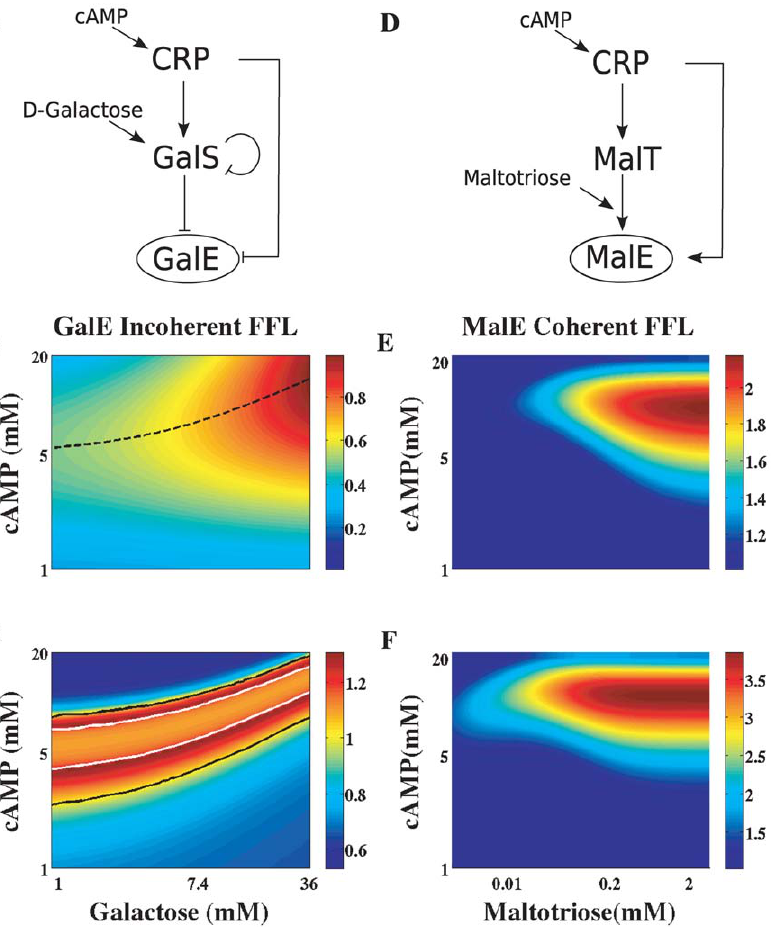
Figure 7. Response features of natural FFLs. Detection properties of FFL circuits involved in sugar metabolism. A. The galETK operon response to cAMP and galactose is mediated by an incoherent FFL interaction, where the external inducers cAMP and D-galactose are required for CRP and GalS activity, respectively. D. The malEFG operon is activated by cAMP and maltotriose through a coherent FFL involving CRP and MalT transcription factors [26]. B. Production rate of the galE- D galR system. A mathematical model was fitted to the experimental input function (Ref. [27] and Text S1). For each galactose concentration, the production rate reaches a maximum at a particular value of external cAMP (shown with the dashed black line). C. Oscillatory bandwidth of the galE- D galR incoherent FFL for the same input ranges. White lines delimit the cAMP boundaries where the system acts as a band-pass frequency filter. Black lines mark the boundaries of partial noise filtering (as illustrated in Figure 6B). E–F. Detection in the presence of noise for the CRP/MalT/MalE coherent FFL. We fitted a simple mathematical model to the experimental input functions (Text S1) to calculate the SNR for both amplitude and frequency detection as a function of both inputs. E. Amplitude SNR normalized by the maximum SNR obtained setting the direct cAMP/malE interaction to zero (linear cascade limit). F. Frequency SNR normalized by the linear cascade